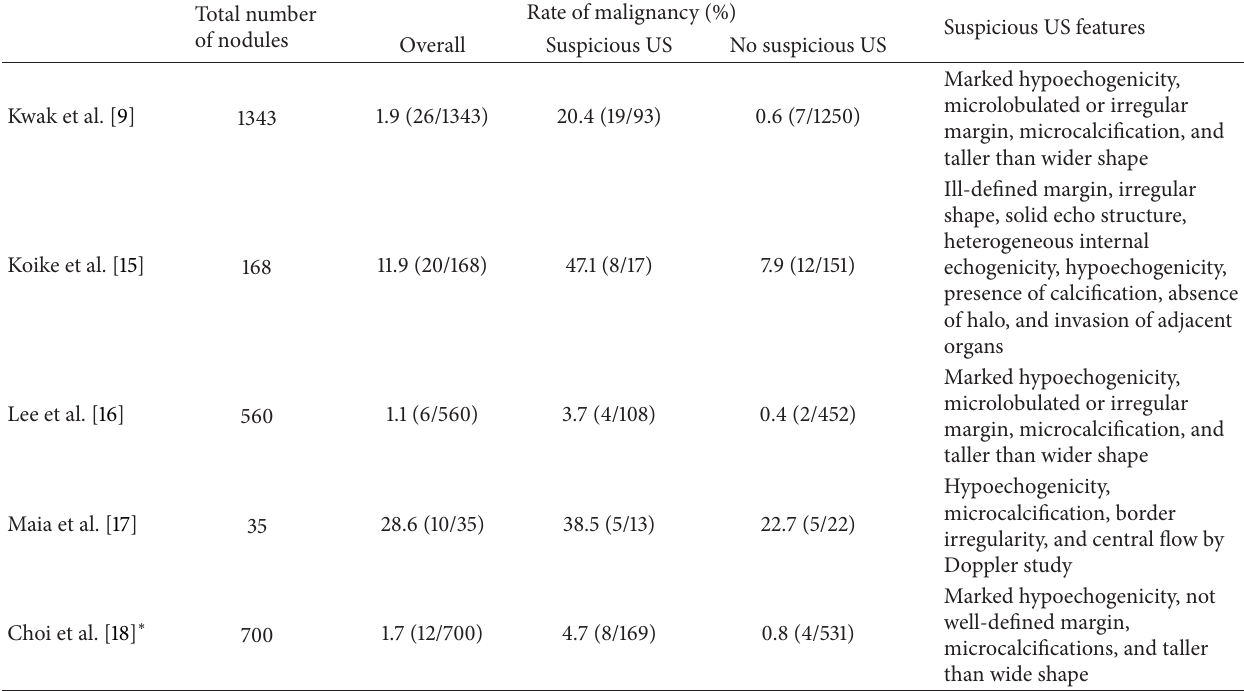
Table 4: Reported rate of malignancy in nodules with benign cytology according to US